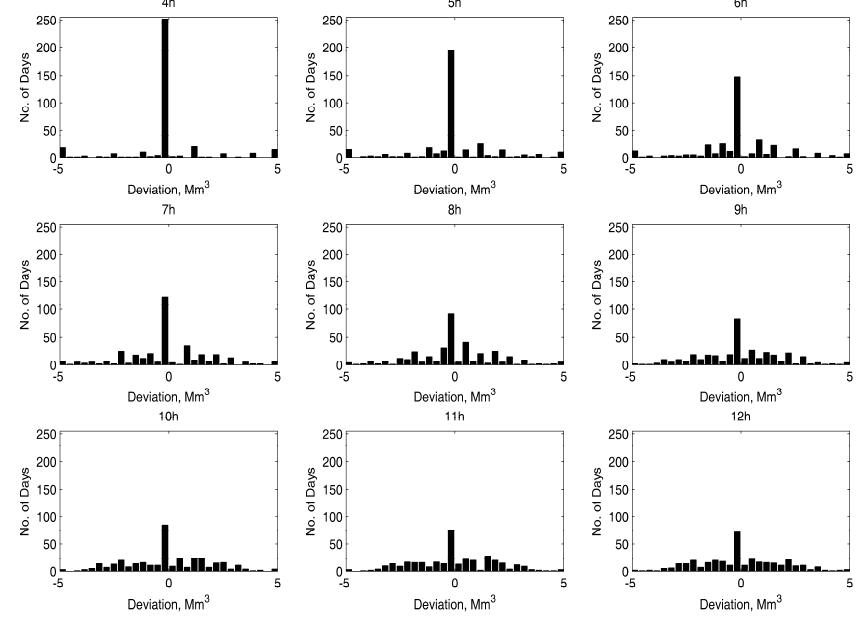
Figure 14. Histogram of the deviations with respect to the daily-cycle operation, of each PSHP participating in the DM.